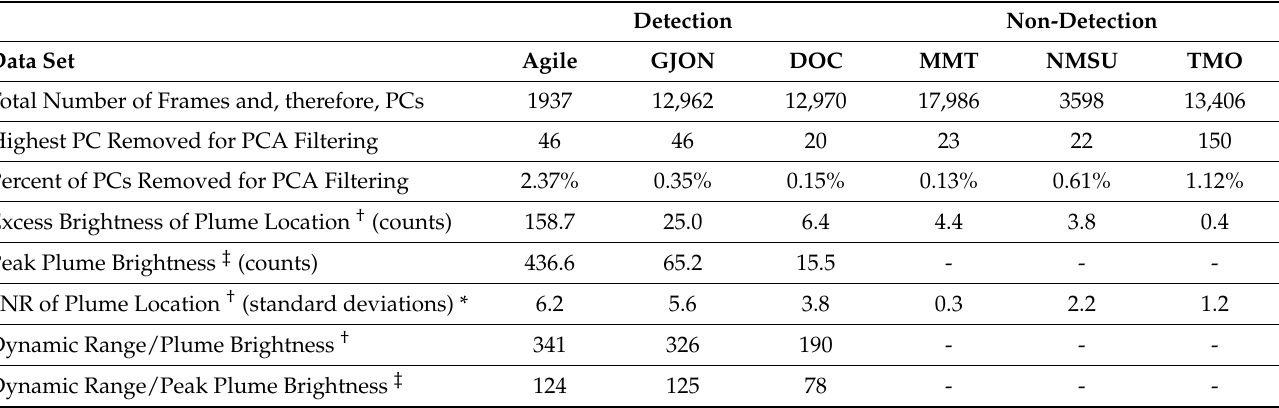
Figure 4. Pixel locations used in analyses overlaid on cropped images of PC1 ( top row ) and the average PCA-filtered data over post-impact times from 17 to 27 s ( bottom row ). The individual pixel outlined in gray in each PC1 image contains the maximum SNR of excess brightness averaged over post-impact times from 15 to 33 s. The individual pixel outlined in white in each PC1 image contains the maximum counts of excess brightness. The outlined region contains the central area of the plume detections for the Strycker et al. [13] Agile data reduction, Agile (this work), GJON, and DOC. For the non-detections of MMT, NMSU, and TMO, the outlined region had the highest likelihood for potential detections. Table 3. Characteristics of each PCA-filtered data set and resulting plume detection. † Averaged across the region indicated in Figure 4 over post-impact times from 17 to 27 s in the PCA-filtered data. The values reported for non-detections indicate the excess brightness in this region due to random fluctuations over this time span and not from a plume-like lightcurve. ‡ The peak plume brightness is the maximum value of excess brightness in counts from a single pixel (see Figure 4) at a single frame after the application of the 2.5 s boxcar average used in all post-PCA filtering analyses. * We calculated standard deviation from a pixel’s or region’s lightcurve during the final 40 s prior to impact to match the approximate duration of post-impact excess brightness. We assume this definition for all subsequent tables and